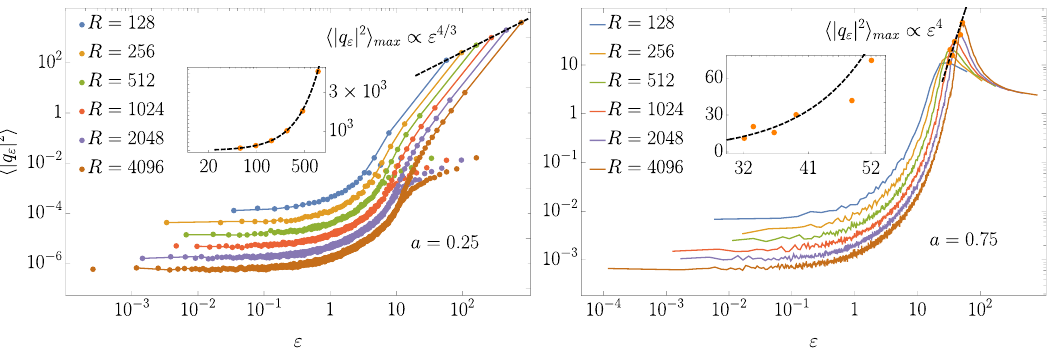
Figure 7: Energy dependence of the maximal effective charge. The dots show the same 〈| q (cid:34) ( R ) | 2 〉 for all positive energies in log-log scale as in the insets to Fig. 6, but without collapsing, black dashed lines show the evolution of the maximal 〈| q (cid:34) ( R ) | 2 〉 and its energy with the increasing cutoff radius according to Eqs. (24c), (25) and (38). The insets show the same maximal points of 〈| q (cid:34) ( R ) | 2 〉 in linear scale with the power-law black dashed fitting curves coinciding with the ones in the main panels. The data is averaged over 10 3